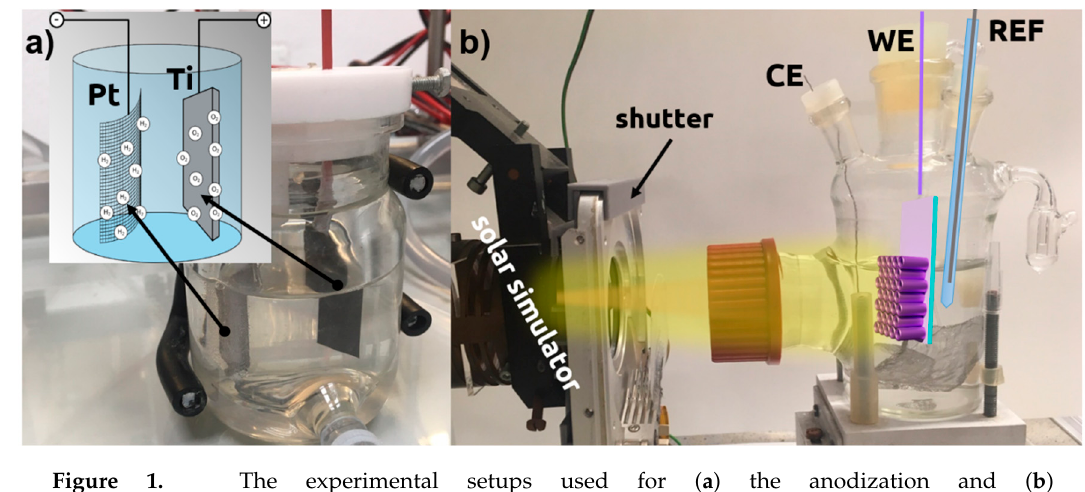
Figure 1. The experimental setups used for ( a ) the anodization and ( b ) photoelectrochemical characterization.